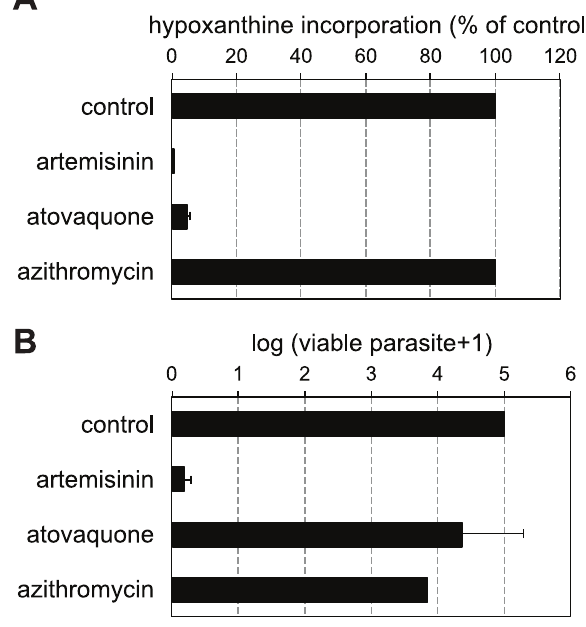
Figure 2. Comparison of metabolic and viability assays. A . P. falciparum radio-labeled hypoxanthine incorporations after 48 hours of drug treatment at concentrations corresponding to 10 6 IC 50 with artemisinin, atovaquone, and azithromycin, reported as percentages of untreated controls. Data are averages of 12 repetitions from two independent experiments B . P. falciparum viability after 48 hours of drug treatment at concentrations corresponding to 10 6 IC 50 with artemisinin, atovaquone, and azithromycin, reported as number of viable parasite, as determined by limiting serial dilutions. Data are averages of 4 independent experiments. In both panels, error bars represent the standard error of the mean (SEM). (DHFR) inhibitor pyrimethamine, as well as atovaquone and Figure 3A, lag phase, PRR and 99.9% PCT values are reported in Table 1. For all the compounds investigated, the number of viable